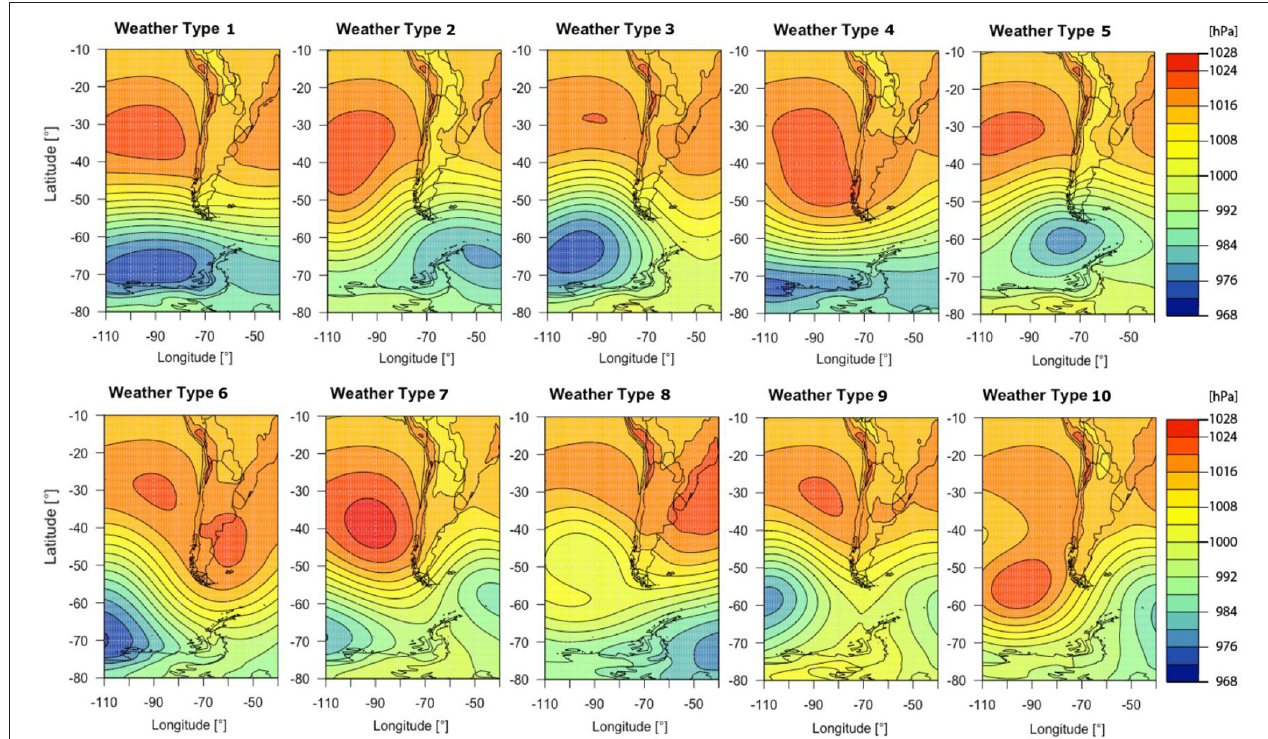
FIGURE 7 | Ten major weather types classified by means of ERA-Interim MSLP reanalysis data for the period 1979 to